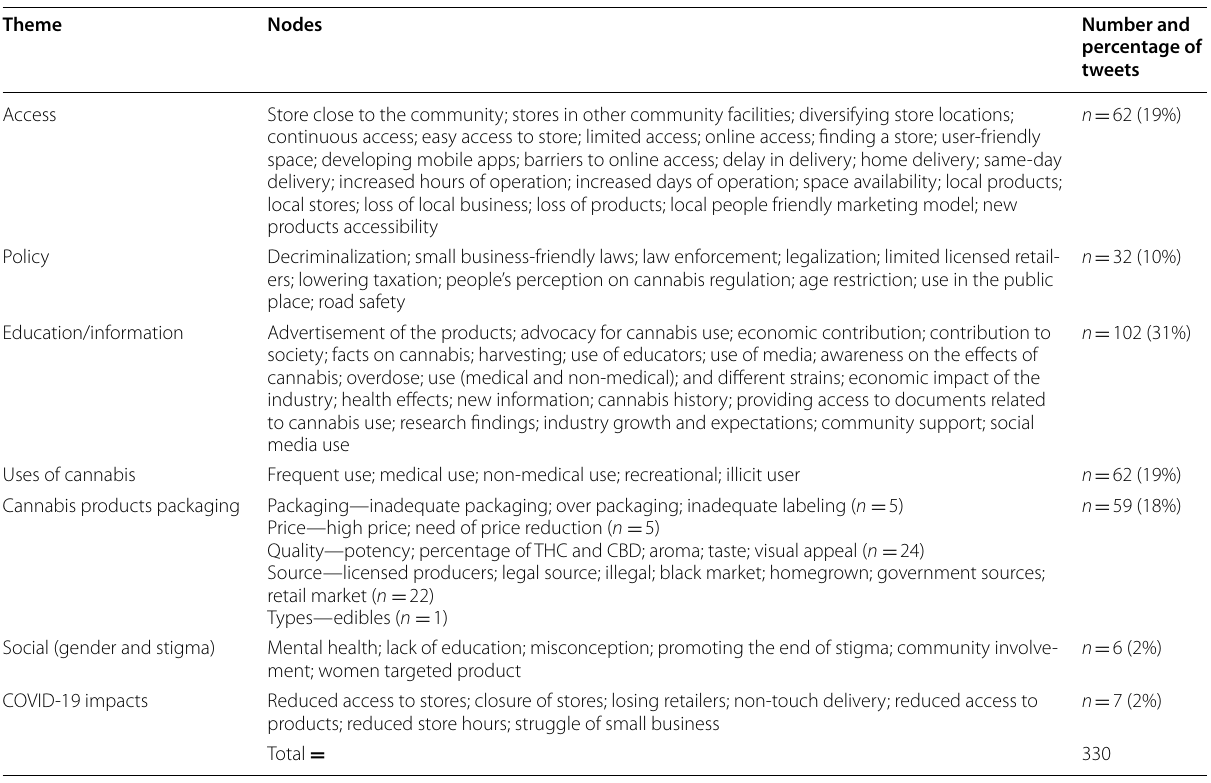
Table 5 Themes and nodes in keyword search